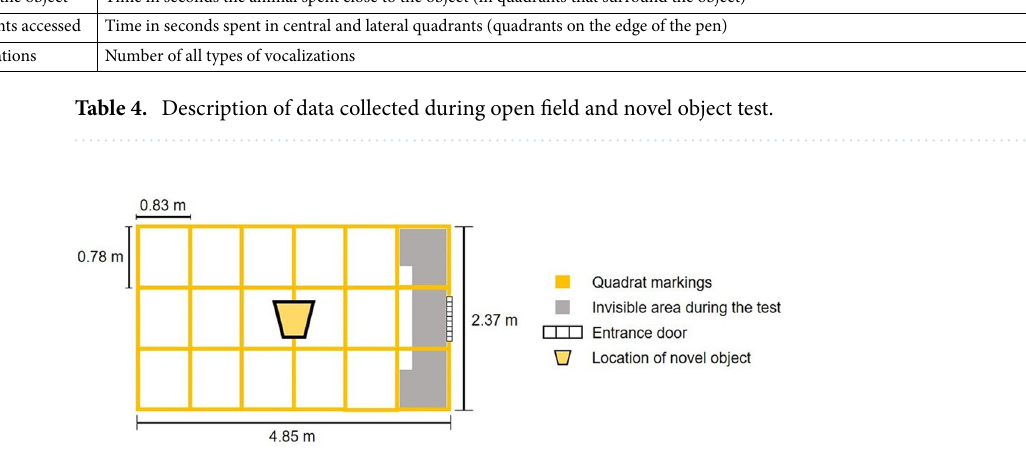
Figure 2. Graphic representation of pen used to perform the open field and novel object